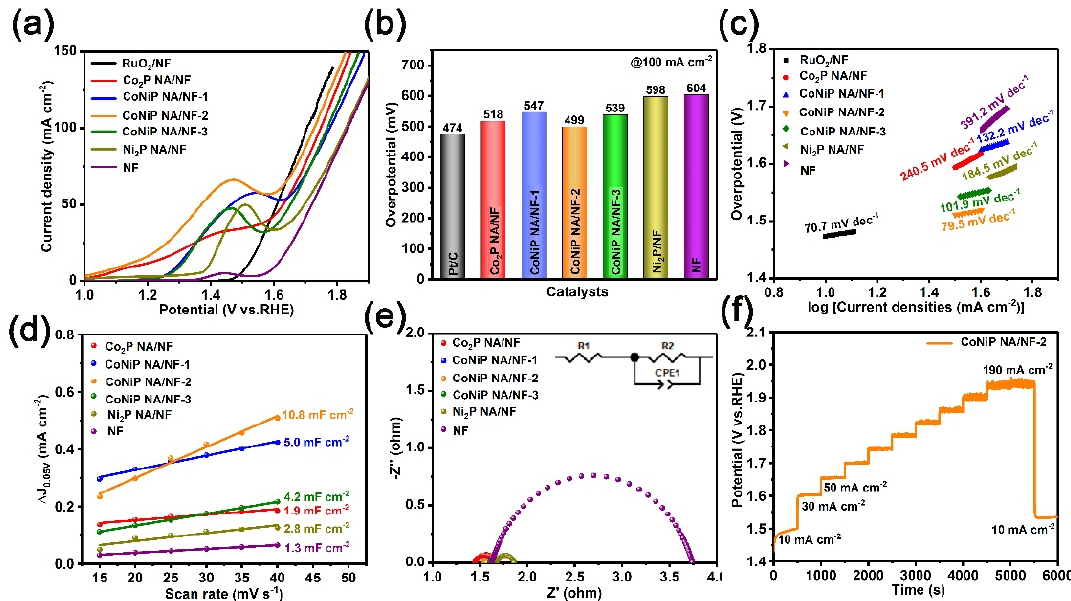
Figure 6. The OER catalytic activity of samples in 1.0 M KOH. ( a ) LSV polarization curves, ( b ) the corresponding overpotentials at η 10 , ( c ) Tafel slopes, ( d ) the C dl and ( e ) the Nyquist curves (the inset is the equivalent circuit) of as-prepared samples. ( f ) Multi-current step chronopotentiometric curves of CoNiP NA/NF.